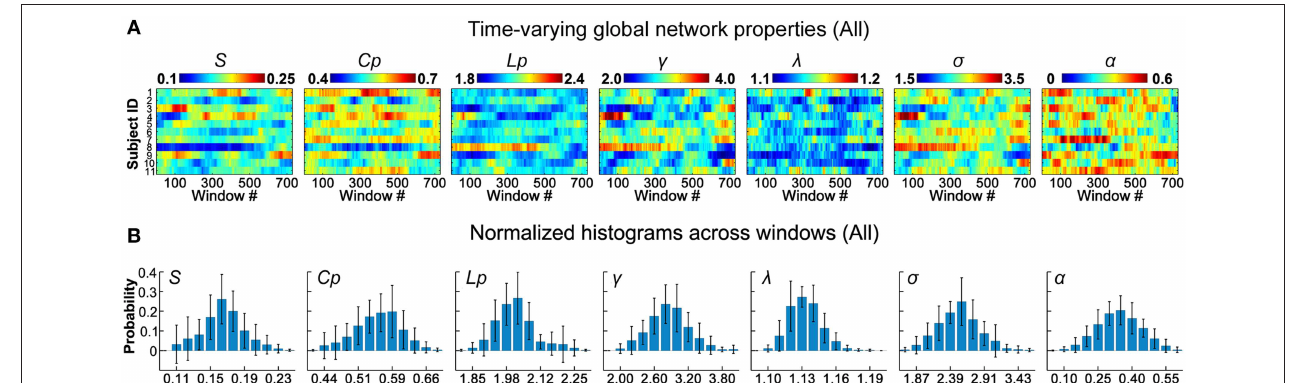
FIGURE 2 | Dynamic global topological properties of D-FC brain networks. (A) Time-varying global network properties for all participants, including sparsity ( S ), clustering coefficient ( C p ), characteristic path length ( L p ), normalized clustering coefficient ( γ ), normalized characteristic path length ( λ ), small-worldness ( σ ), and assortativity ( α ). (B) Normalized histograms of global properties across windows for all participants. For each metric, a normalized histogram across windows was estimated for each participant; these histograms were then averaged across participants to generate the mean histogram. Error bars represent the standard deviation of the normalized histograms across participants. D-FC, dynamic functional connectivity.